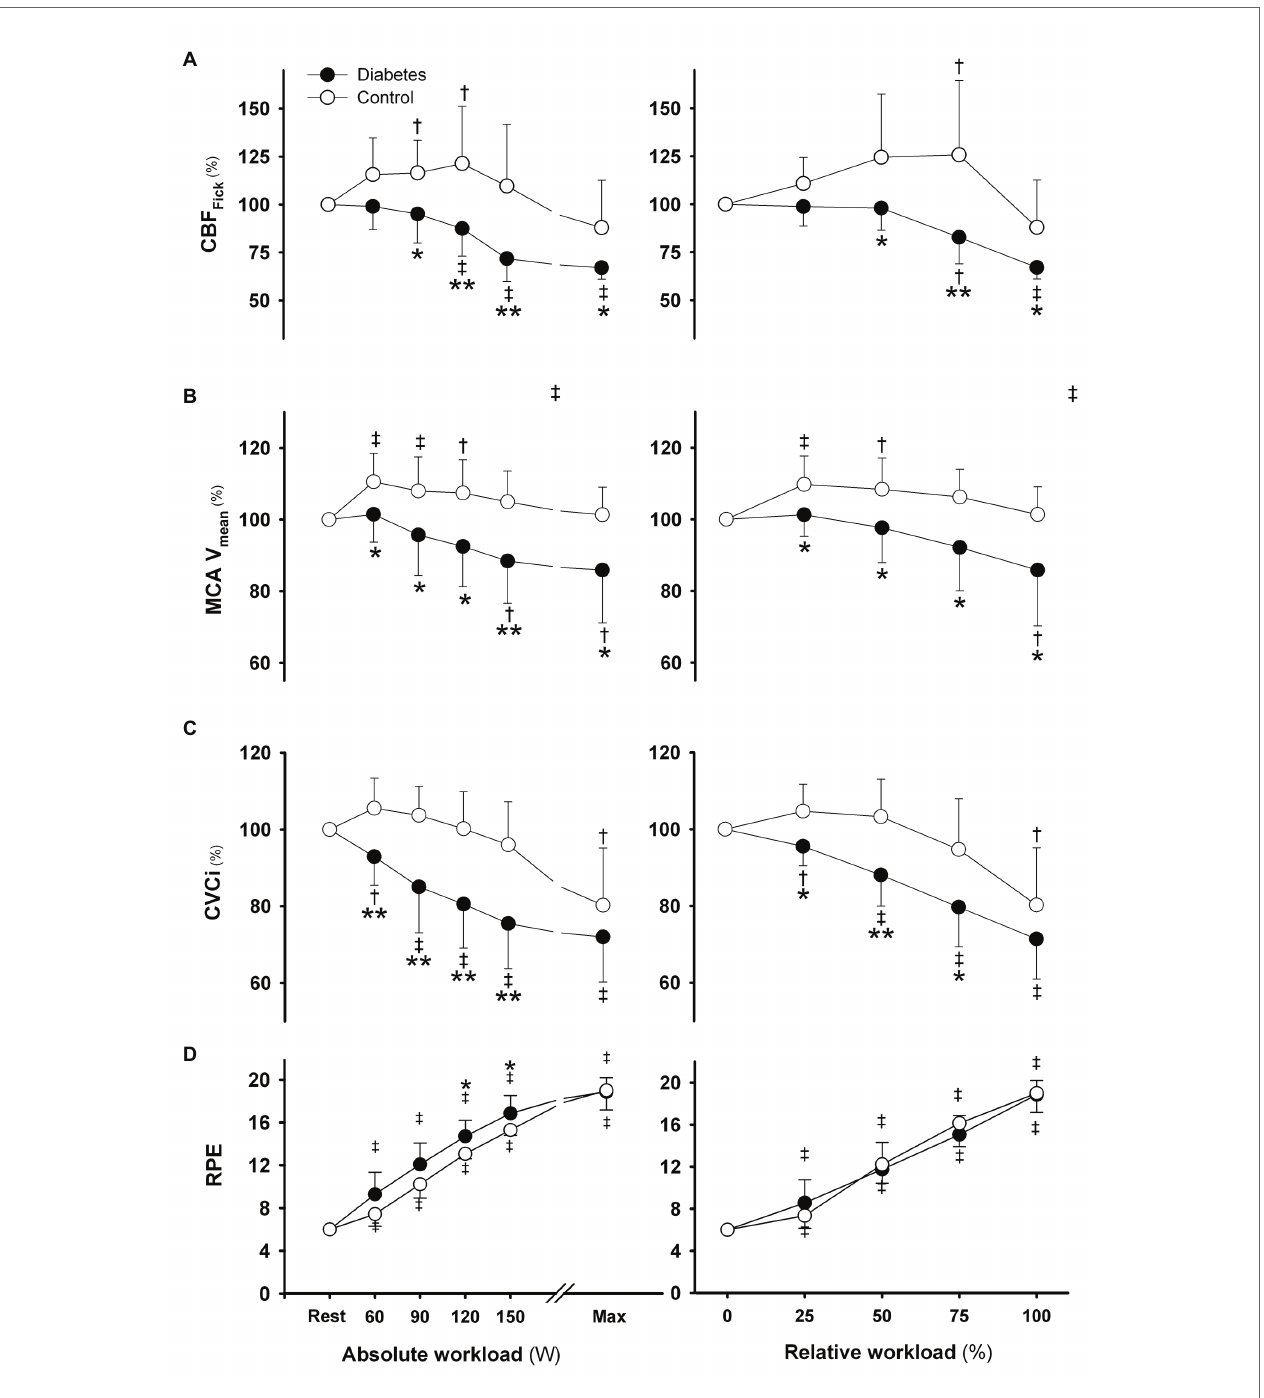
FIGURE 1 | Cerebrovascular response to exercise in eight male type 2 diabetic patients without symptomatic cardio-vascular disease (closed circles) vs. seven age and gender matched healthy subjects (open circles) at the same absolute (left panels) and relative workload (right panels). (A) Cerebral blood flow derived from the Fick principle (CBF Fick ) from inverse arterial-jugular venous oxygen difference, (B) middle cerebral artery mean blood flow velocity (MCA V mean ), (C) cerebrovascular conductance index (CVCi), and (D) rating of perceived exertion (RPE; Borg scale). The patients demonstrated a decline in cerebral perfusion and oxygenation during incremental exercise associated with attenuated increases in cerebral and systemic vascular conductance compared with healthy controls. Cerebral oxygenation reached its lowest level at exhaustion at a 20% lower workload in type 2 diabetes mellitus (T2DM) patients than healthy controls and patients expressed a higher RPE than healthy controls. † p < 0.05 and ‡ p < 0.01 vs. rest; * p < 0.05 and ** p < 0.01 vs. control subjects. Values are mean ± SD (modified from Kim et al.,